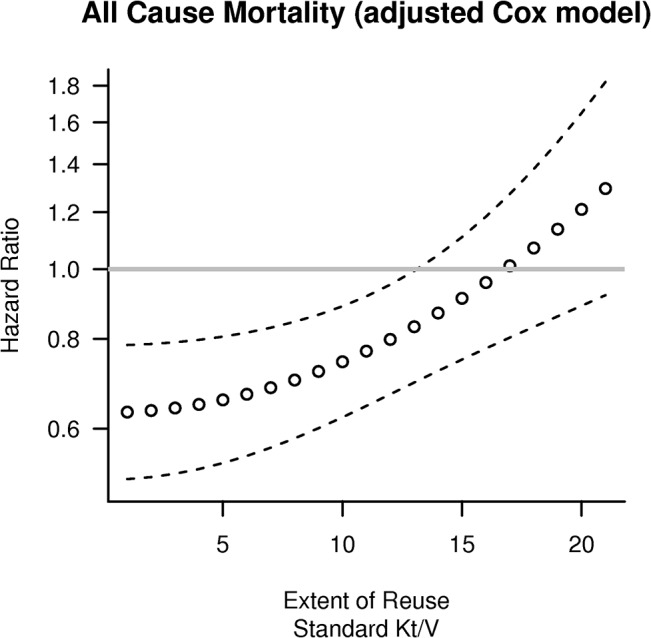
Predicted Hazard Ratio (HR) of High Flux(HF) dialysis as a function of membrane reuse.Predictions were obtained by fitting a meta-regression model to adjusted (for age, gender, diabetes, vascular access and comorbidity score) HR of subgroups of HEMO (defined on the basis of reuse quartiles, Kt/V and flux) and MPO. The meta-regression model accounted for Kt/V and the (square) of the extent of reuse. Of note, reuse of HF membranes up to 13 times appears to yield a protective effect with a predicted RR of 0.83, and an associated 95% CI: 0.70–0.99 that excludes unity.